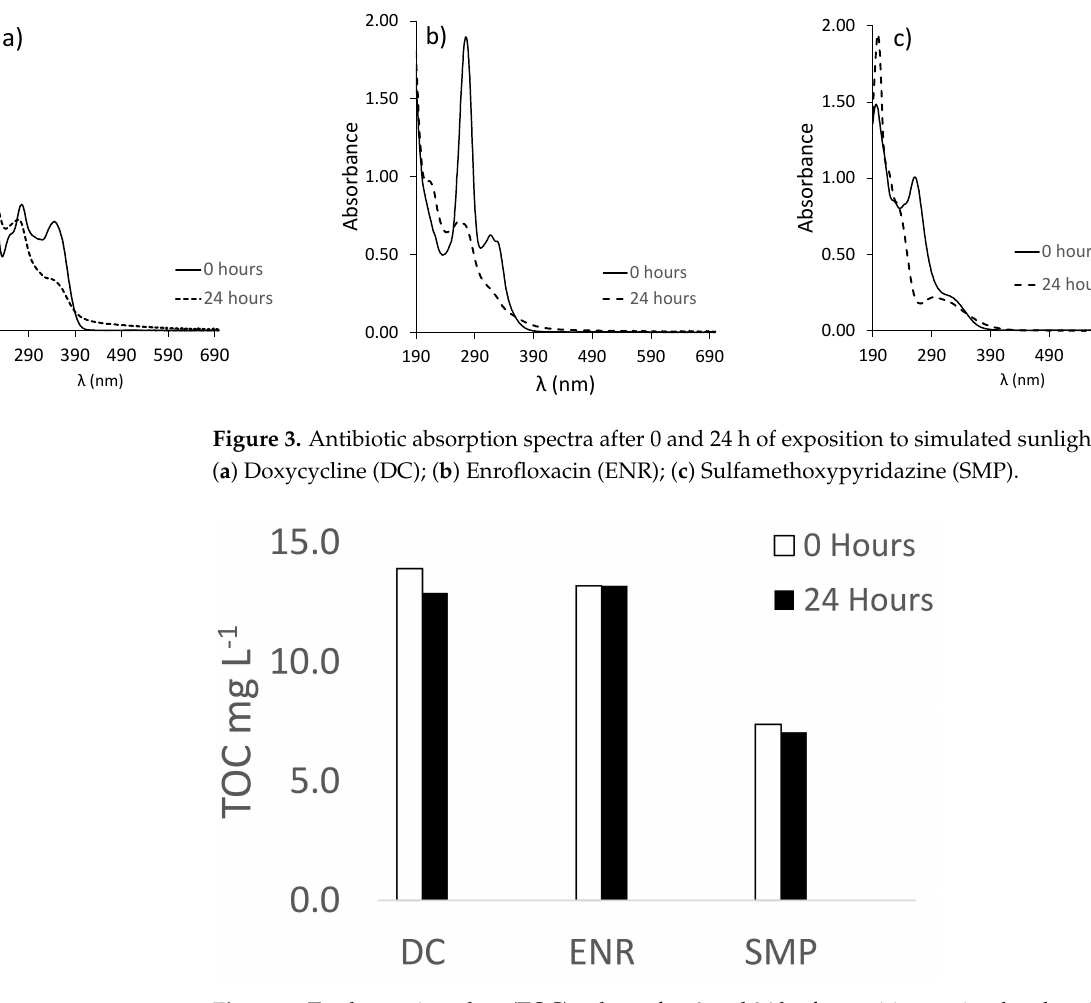
Figure 4. Total organic carbon (TOC) values after 0 and 24 h of exposition to simulated sunlight at pH 5.5. Doxycycline (DC); Enrofloxacin (ENR); Sulfamethoxypyridazine (SMP). Coefficients of variation were always lower than